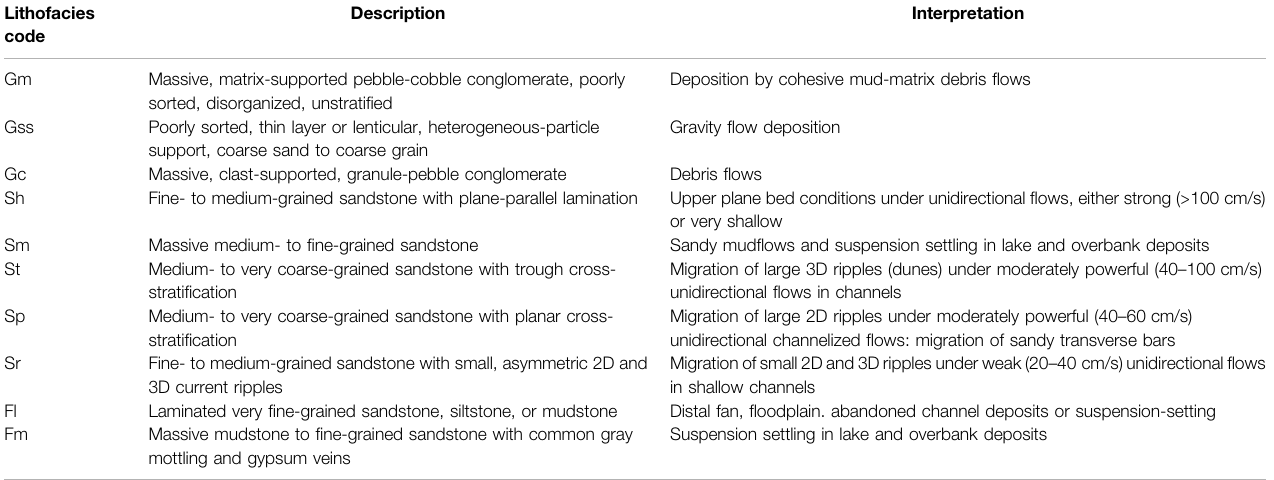
TABLE 1 | Lithofacies used in measured sections and interpretations in this